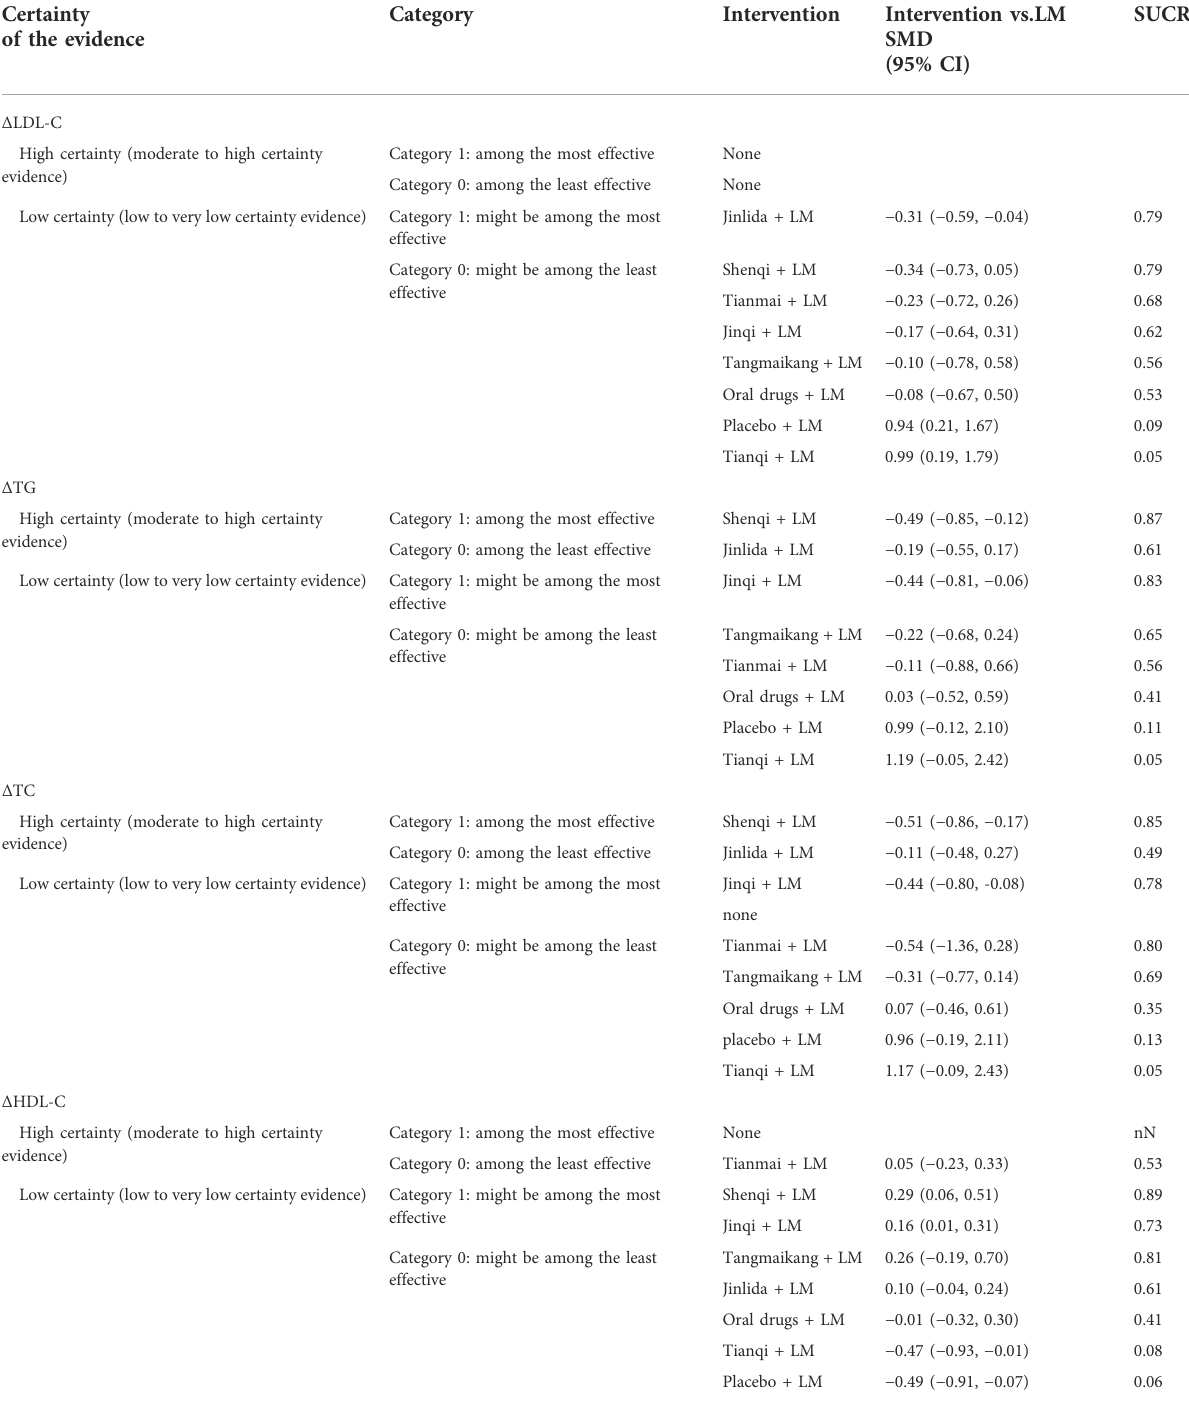
TABLE 5 Final classi fi cation of 8 interventions for